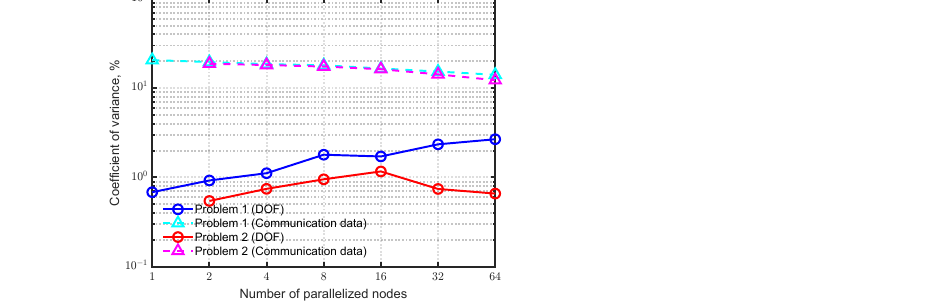
Figure 4. Coefficients of variance for distribution of DOF and communication data per communication among all subdomains for each parallel condition.